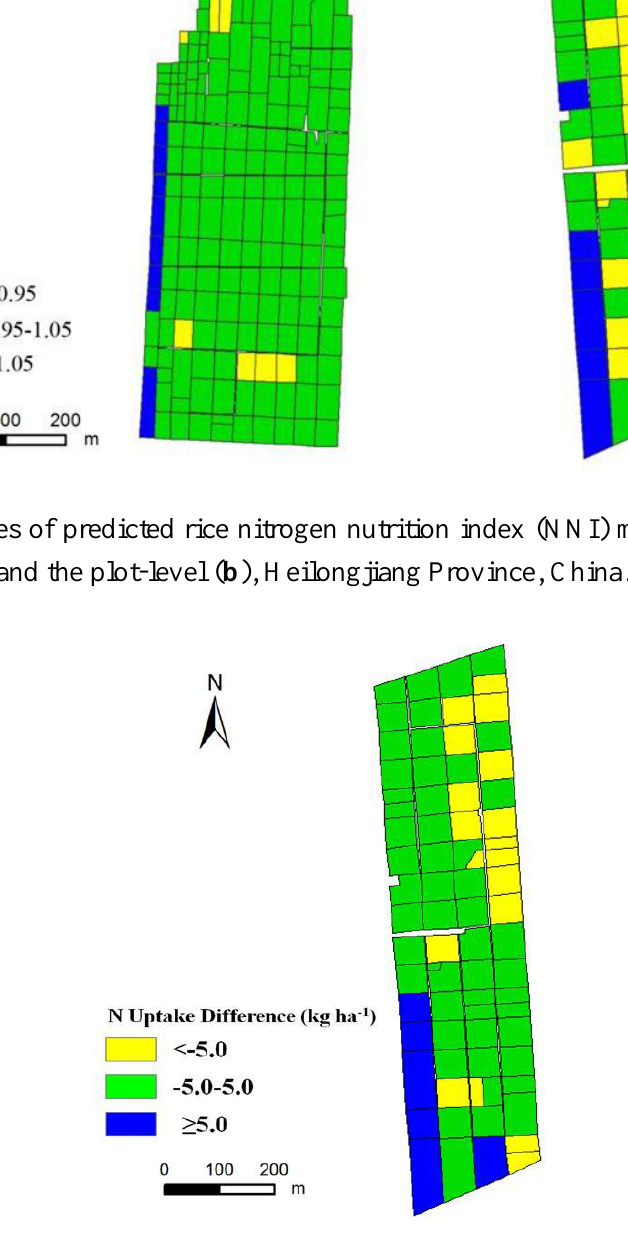
Figure 4. Example of a plant N uptake difference map of a farmer’s field, Heilongjiang Province,